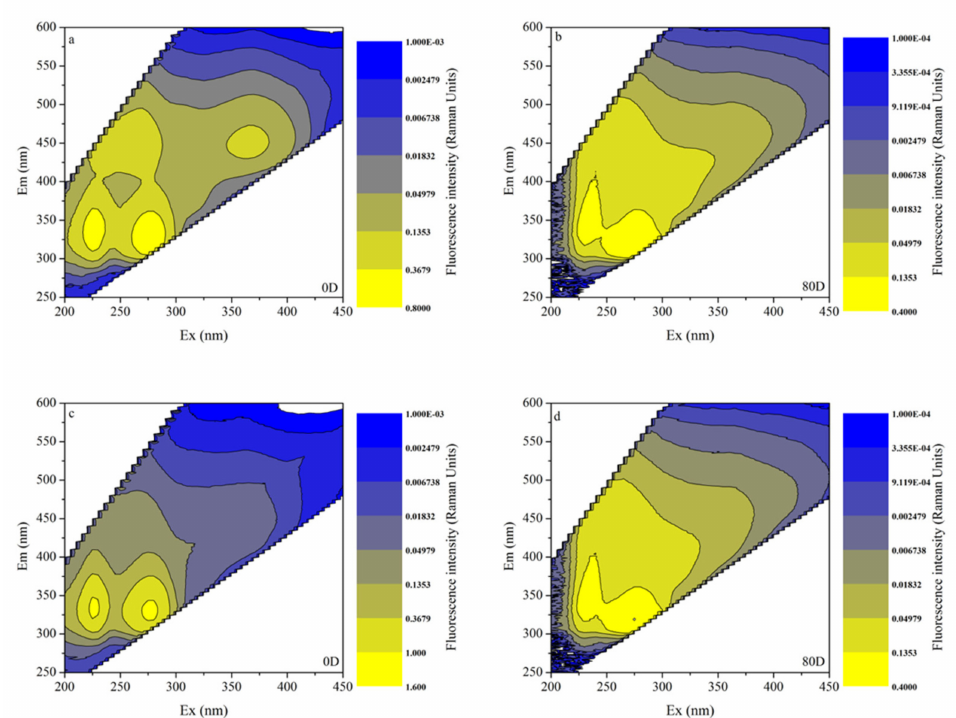
Figure 5. Chromophoric dissolved organic matter (CDOM) fluorescence properties presented by excitation-emission matrix spectra (EEMs) for the algal-derived filtrate group on ( a ) day 0 and ( b ) day 80, and for the algal residual exudative organic matter group on ( c ) day 0 and ( d ) day